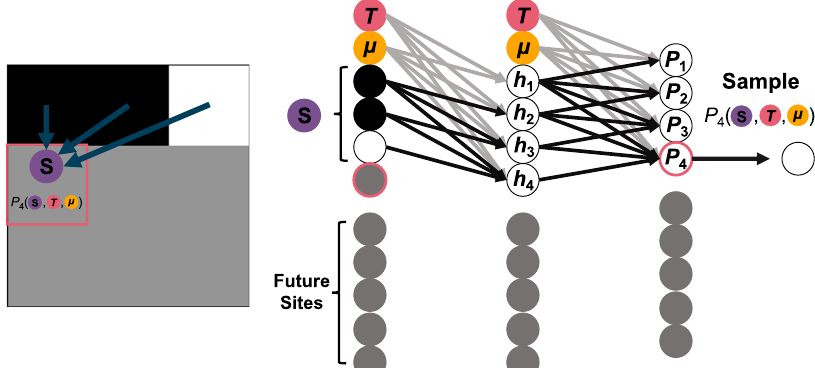
Fig. 1 Architecture. Two-layer SEGAL model restricting dependence of all sites to previous sites and thermodynamic constraints. Each node shown in the fi gure represents a group of n neurons for an n -component